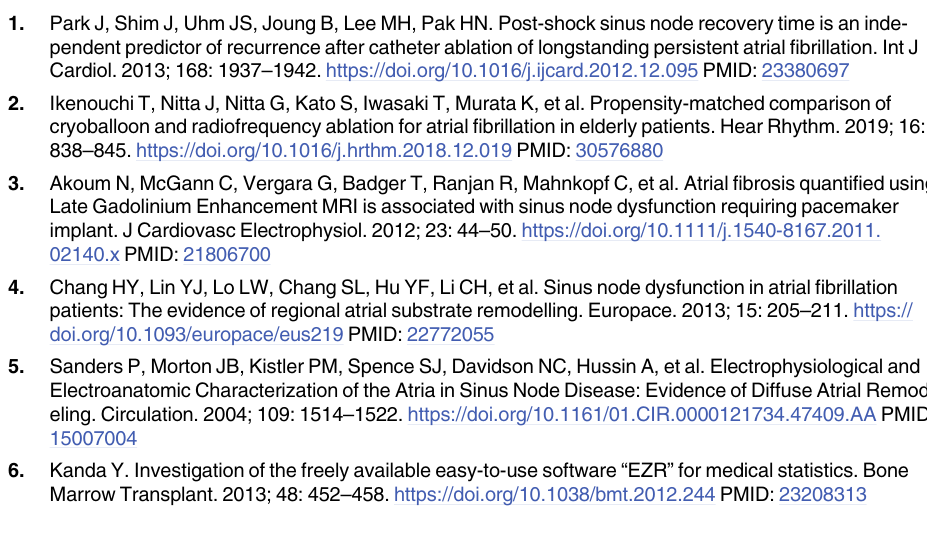
S1 Table. Relationship between SNRT and